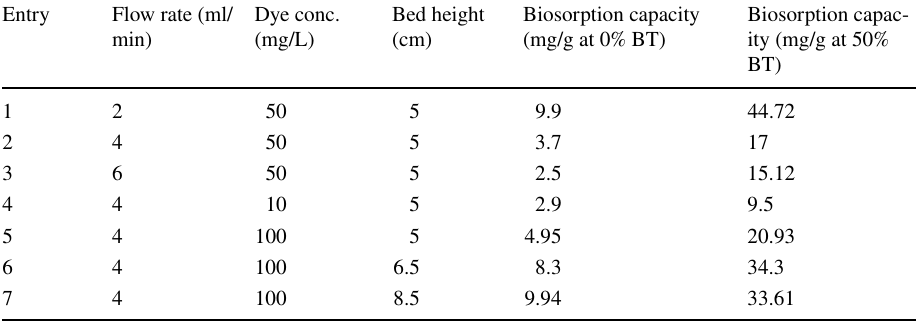
Table 4 Effect of various parameters on column biosorption studies of dye EB on